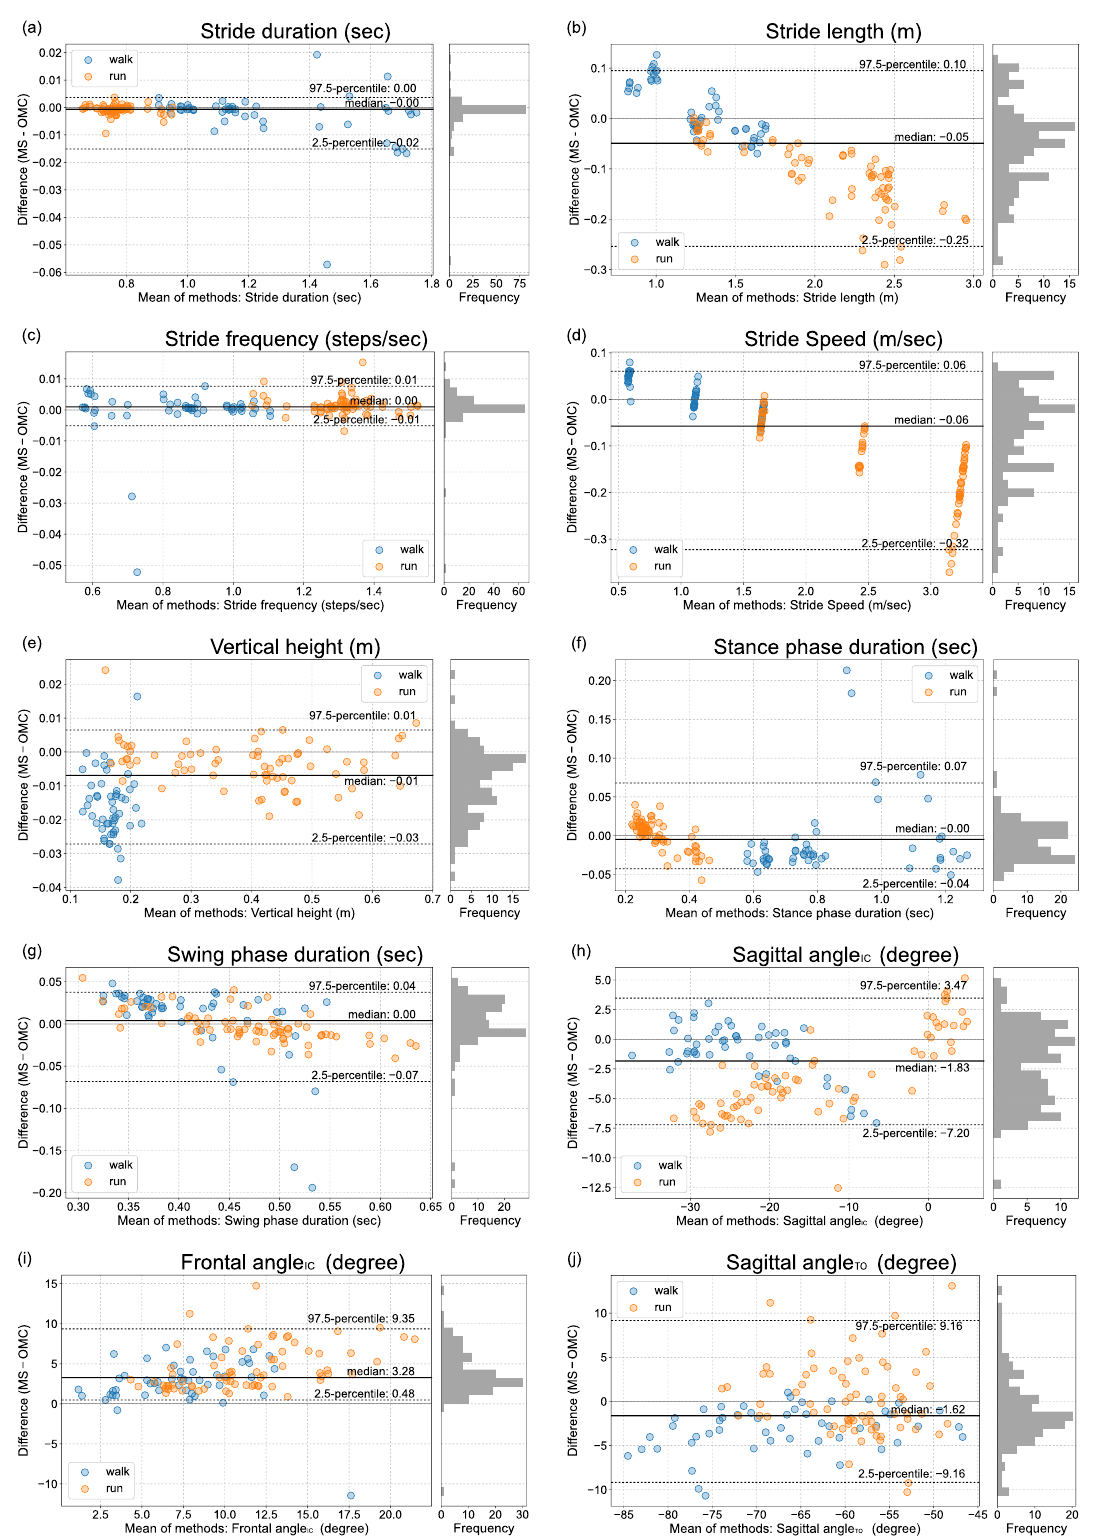
Figure 2. Bland–Altman plot of gait parameters from the motion sensor embedded in the shoe midsole (plantar-embedded) and optical motion capture. ( a ) stride duration, ( b ) stride length, ( c ) stride frequency, ( d ) stride speed, ( e ) vertical height, ( f ) stance phase duration, ( g ) swing phase duration, ( h ) sagittal angle IC , ( i ) frontal angle IC , ( j ) sagittal angle TO , MS: motion sensor, OMC: optical motion capture.